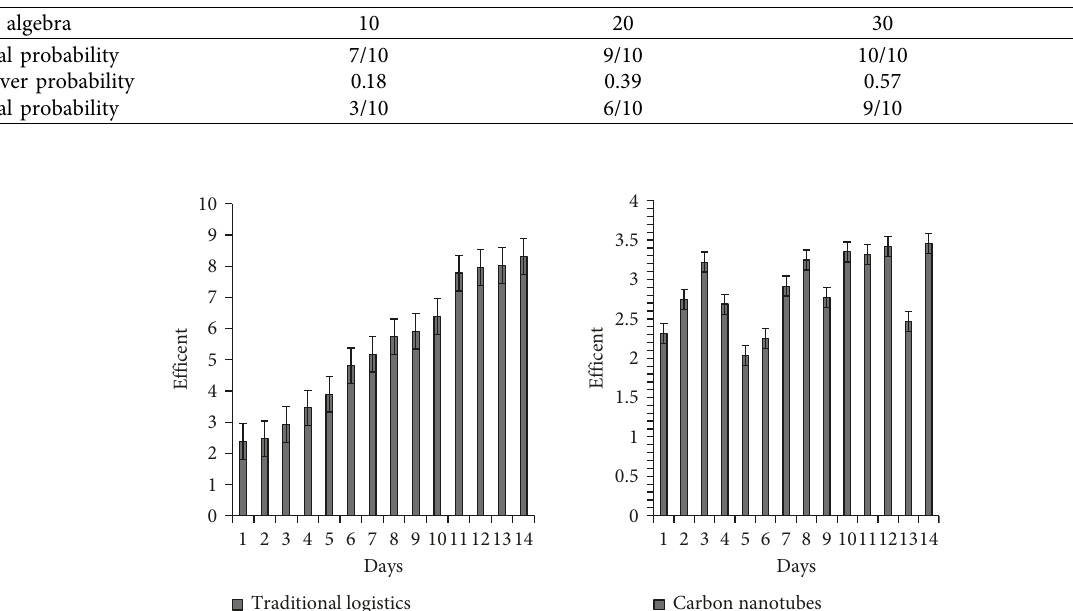
Table 3: Probability results.